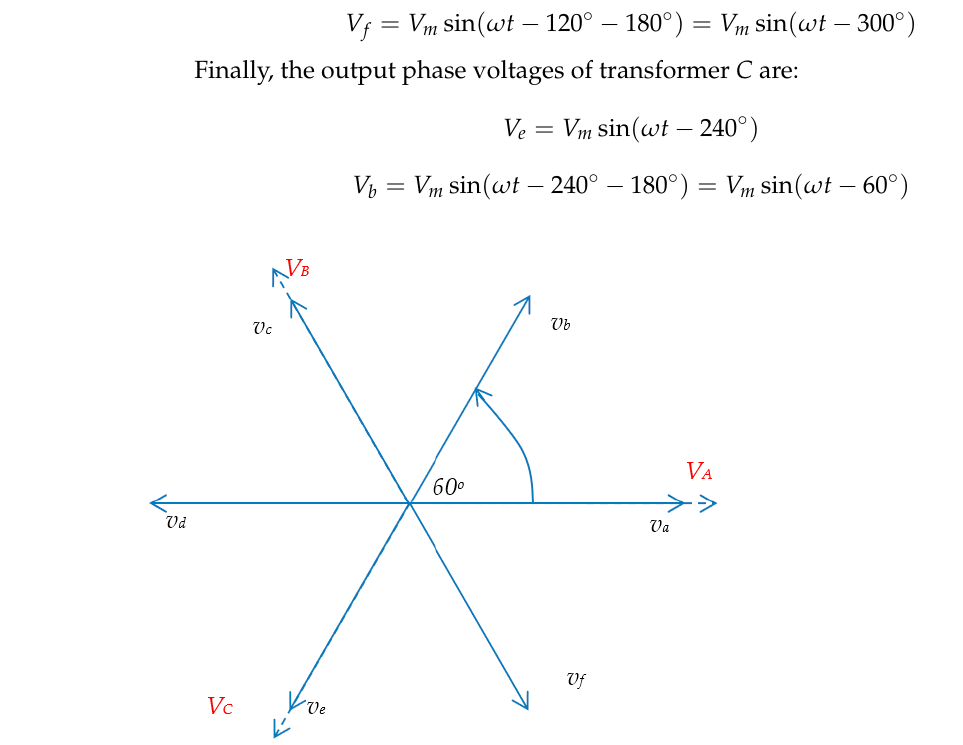
Figure 2. Phasor diagram of three and six-phase voltages.